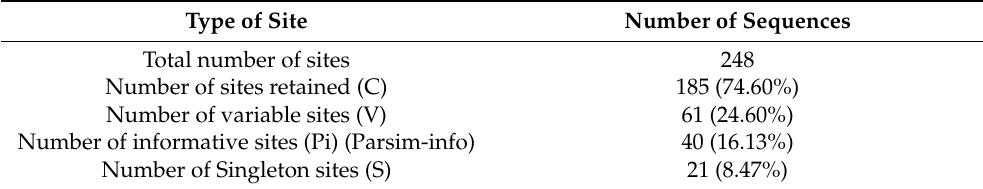
Table 2. Site characterization of the sequences